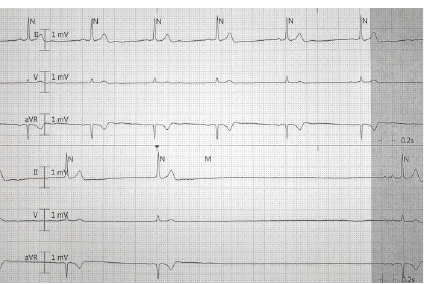
Figure 1: Telemetry rhythm strip demonstrates sinus bradycardia preceding a sinus pause.